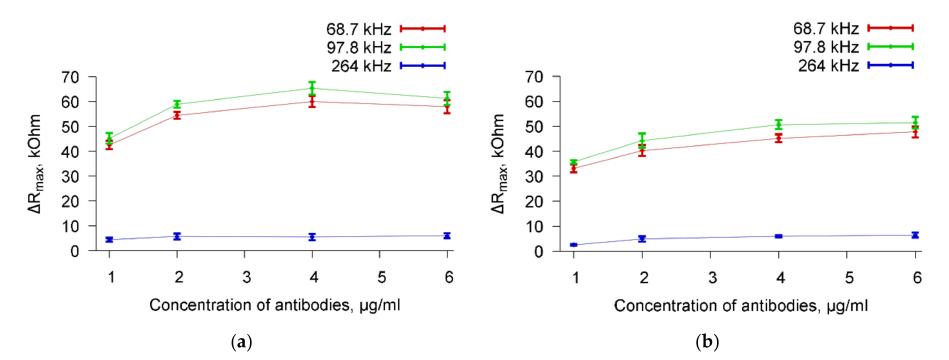
Figure 10. Dependencies of the change of ∆ R max of the resonator on the Abs concentration for A. brasilense Sp7 cell suspension after adding the specific Abs for resonance peaks near frequencies 68.7, 97.8, and 264 kHz. The cell concentration is 10 3 ( a ) and 10 8 ( b ) cells /